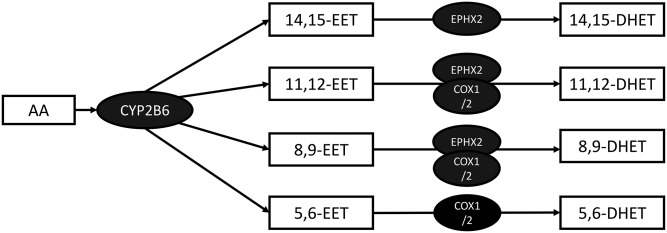
Biochemical pathway leading from AA into DHETs.